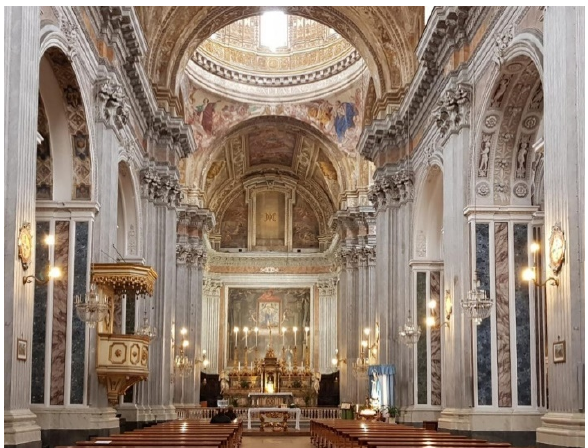
Figure 1. Interior view of the Church of Santa Maria degli